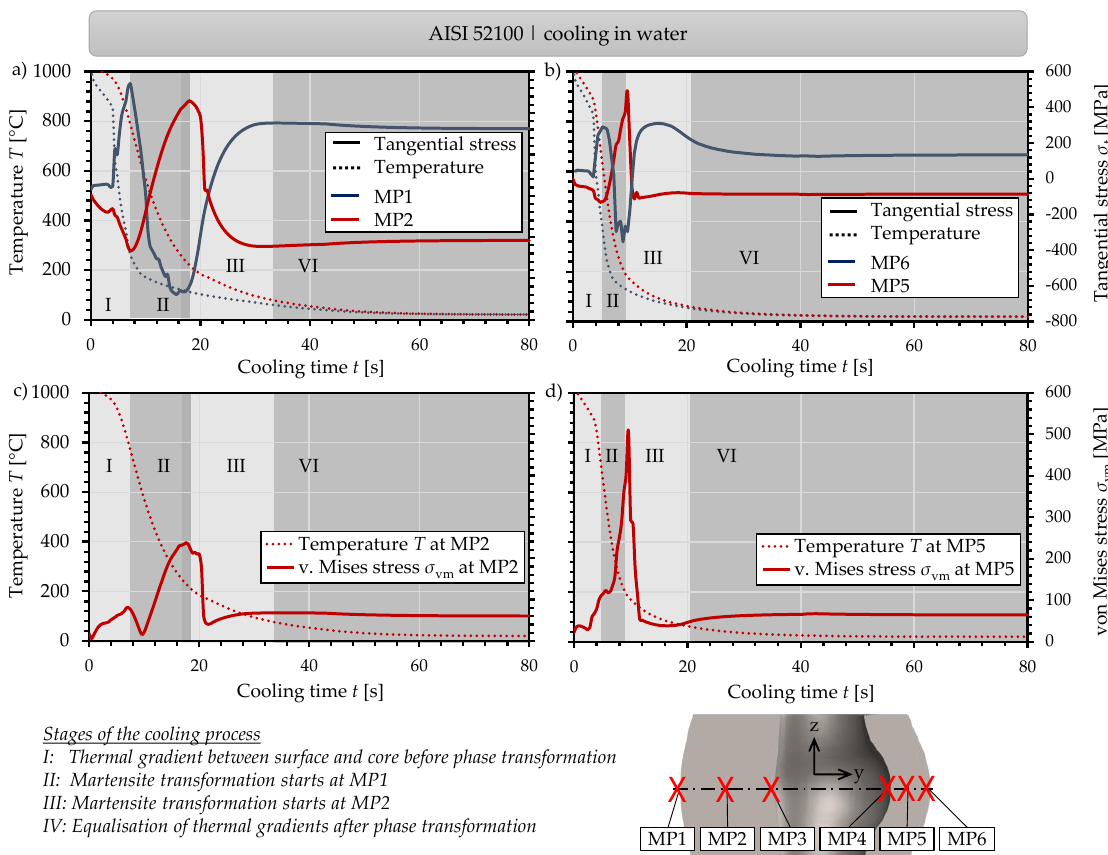
Figure 7. Temporal development of the temperature and angential stresses on the thick-walled side at MP1 and MP2 ( a ), and on the thin-walled side at MP5 and MP6 ( b ) during the cooling of the material AISI 52100 in water, supported by the temporal development of the von Mises stress at MP2 ( c ) and MP5 ( d ).